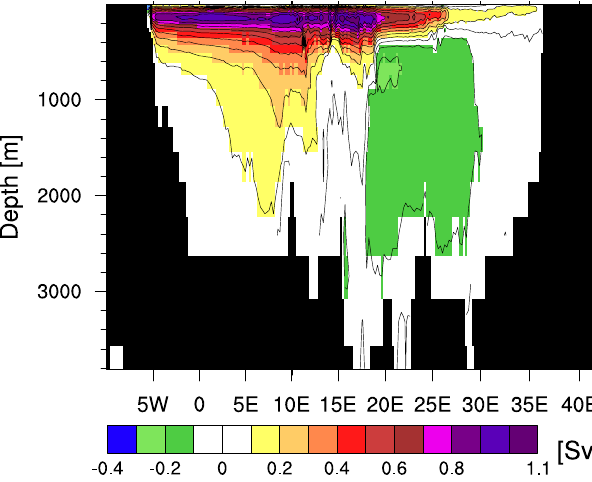
Fig. 4. Zonal overturning stream function integrated over the entire Mediterranean basin for the CTRL experiment. It has been calcu- lated on the basis of a 100-yr mean velocity